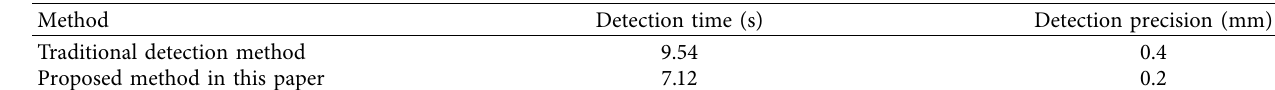
Table 3: Comparison results of detection